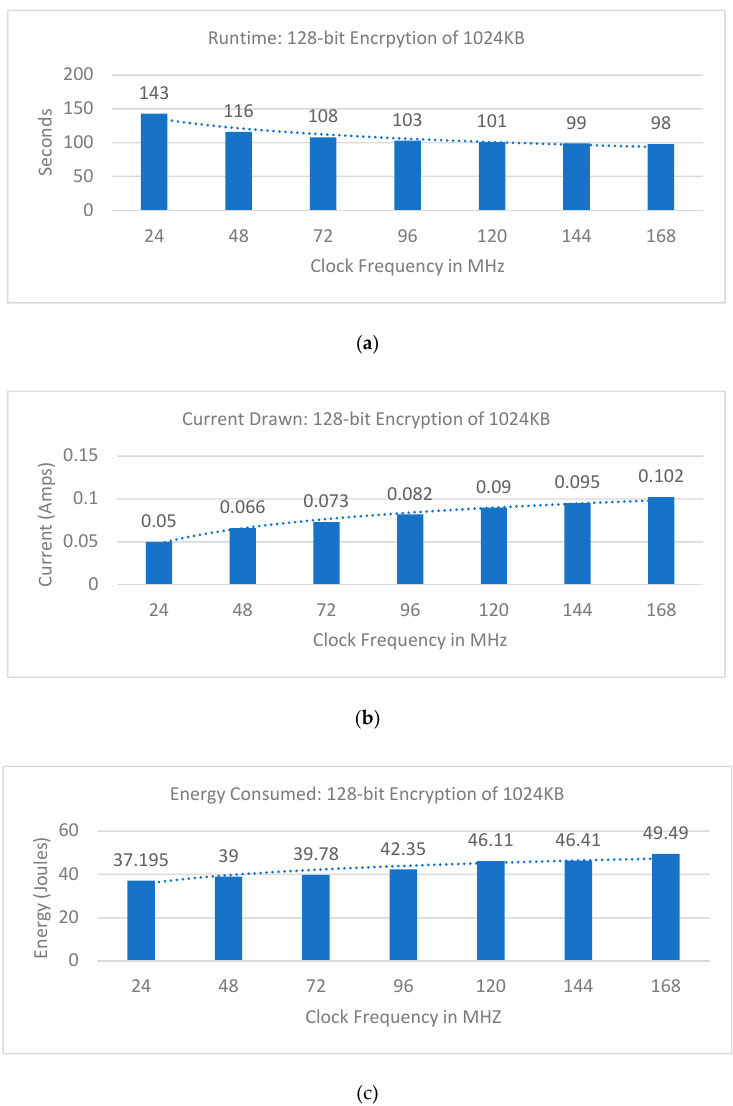
Figure 5. ( a ) Runtime in seconds for each clock frequency scenario shows runtime diminishing returns per increase in clock speed; ( b ) each current drawn in amps shows a plateauing trend for each increment in clock frequency; ( c ) the resulting energy consumed in joules or each increment in clock frequency shows a diminishing growth.